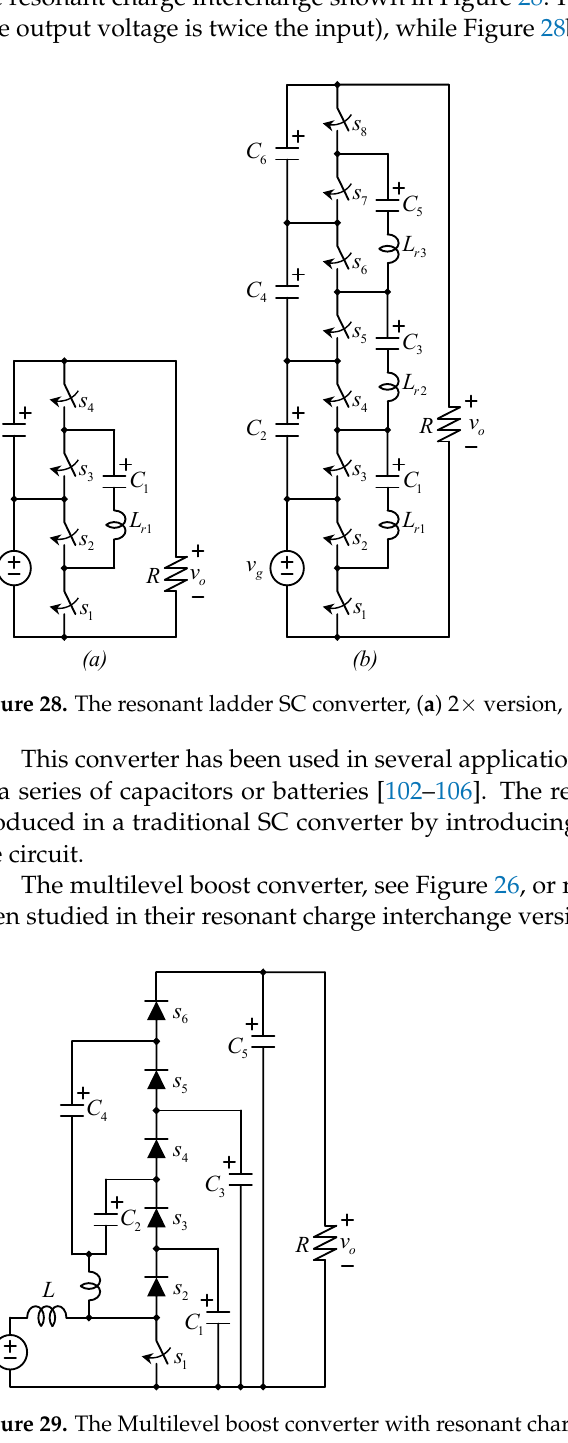
the resonant charge interchange shown in Figure 28. Figure 28a shows the 2 × multiplier (the output voltage is twice the input), while Figure 28b shows the 4 × converter.